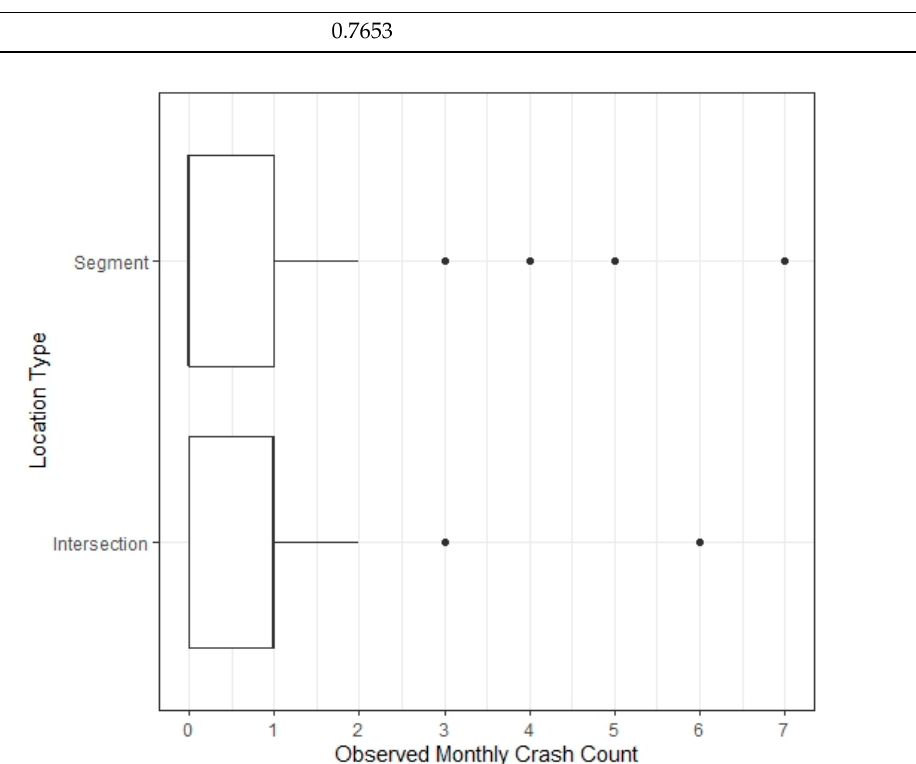
Figure 3. Segment fitted crash counts versus observed crash counts.